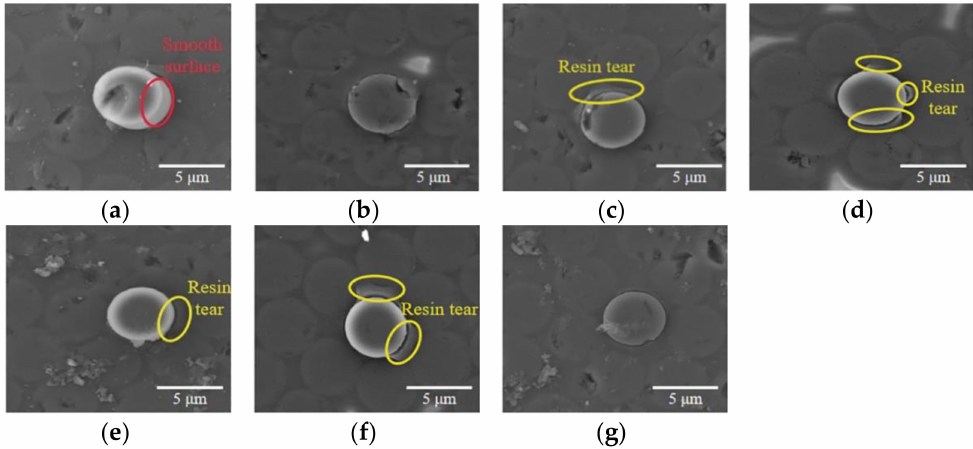
Figure 6. SEM micrographs of the typical pushed fiber, ( a ) 0.0 MPa autoclave process, ( b ) 0.2 MPa autoclave process, ( c ) 0.4 MPa autoclave process, ( d ) 0.6 MPa autoclave process, ( e ) 5 g RVAVP, ( f ) 10 g RVAVP, ( g ) 15 g